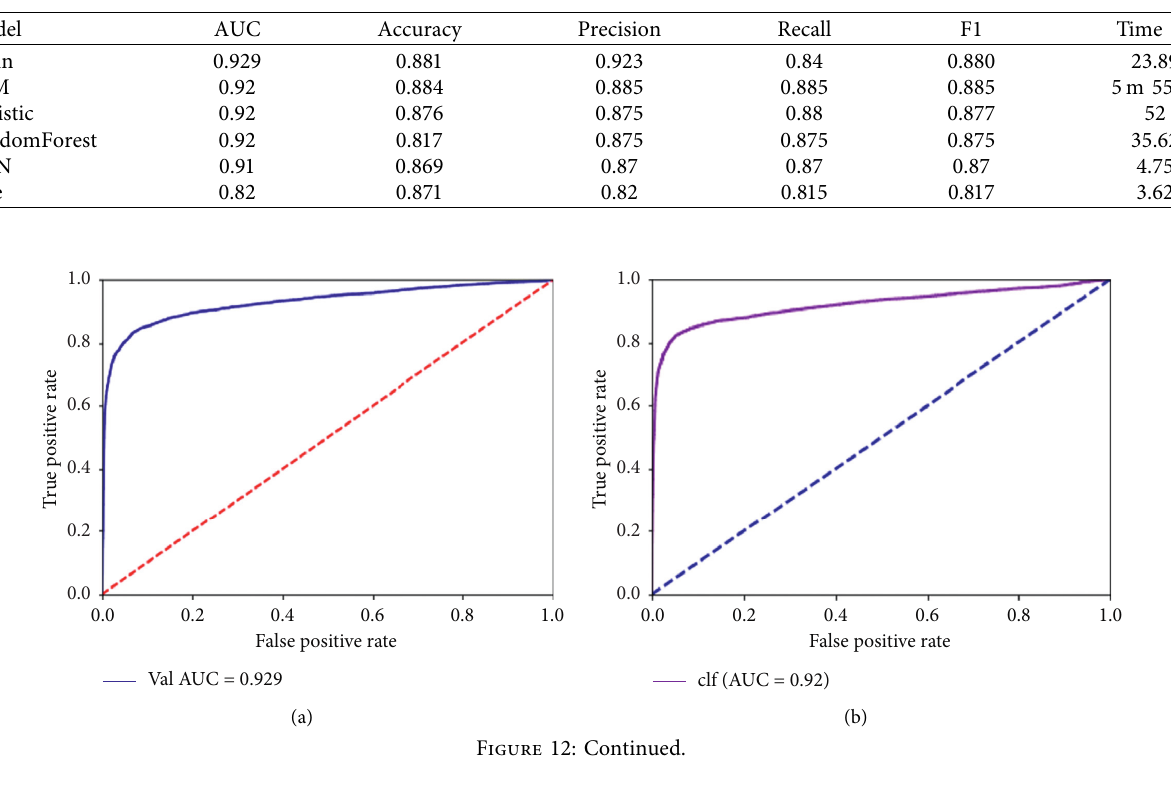
Table 4: Comparison results of six models.